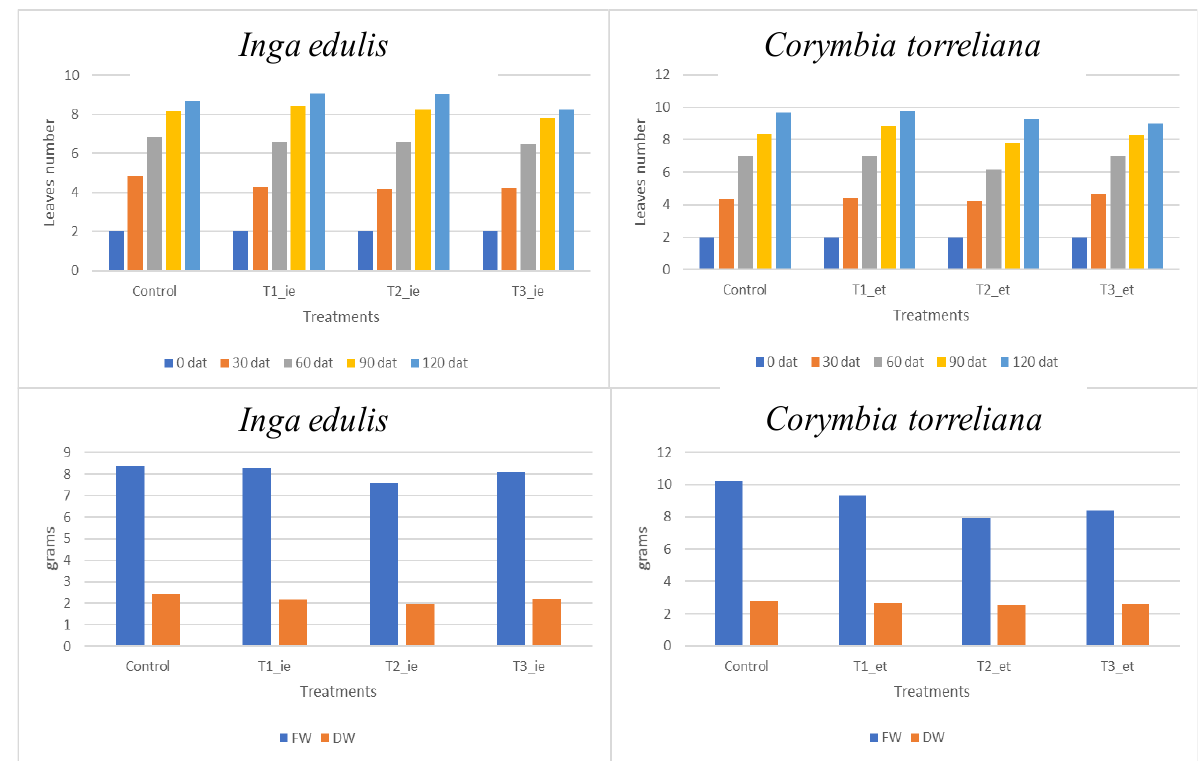
Figure 2. Numbers of leaves and fresh and dry weights (g) of coffee (Coffea arabica ‘Caturra Roja’) plants treated with foliar extracts of guaba (Inga edulis) and cadaghi (Corymbia torrelliana) under nursery conditions in Chanchamayo, Peru. dat, days after transplant; FW, fresh weight; DW, dry weight. See Table 2 for a description of the